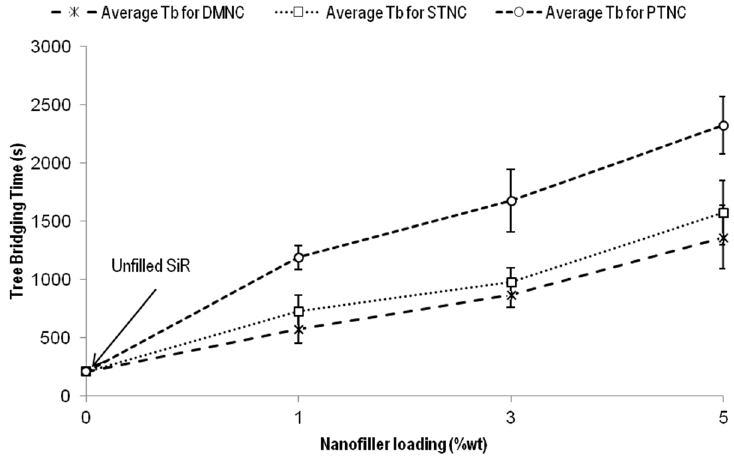
Figure 9. Tree bridging times for DMNC, STNC, and PTNC.